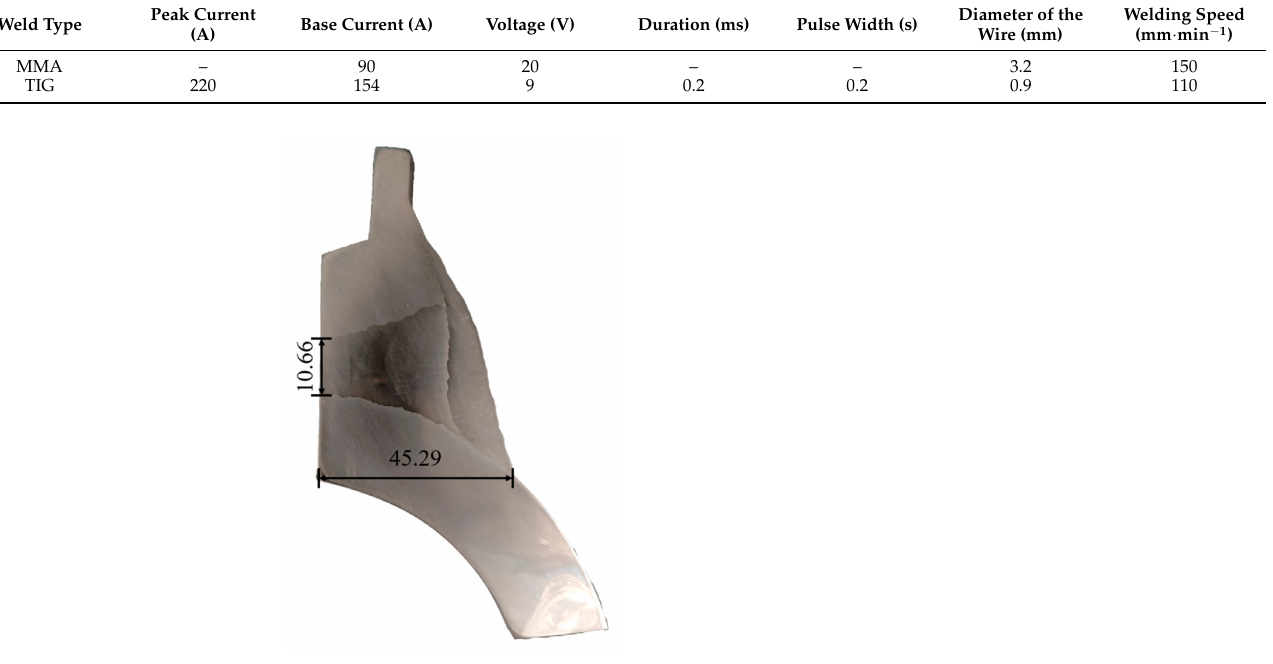
Figure 3. Dimension of overlay